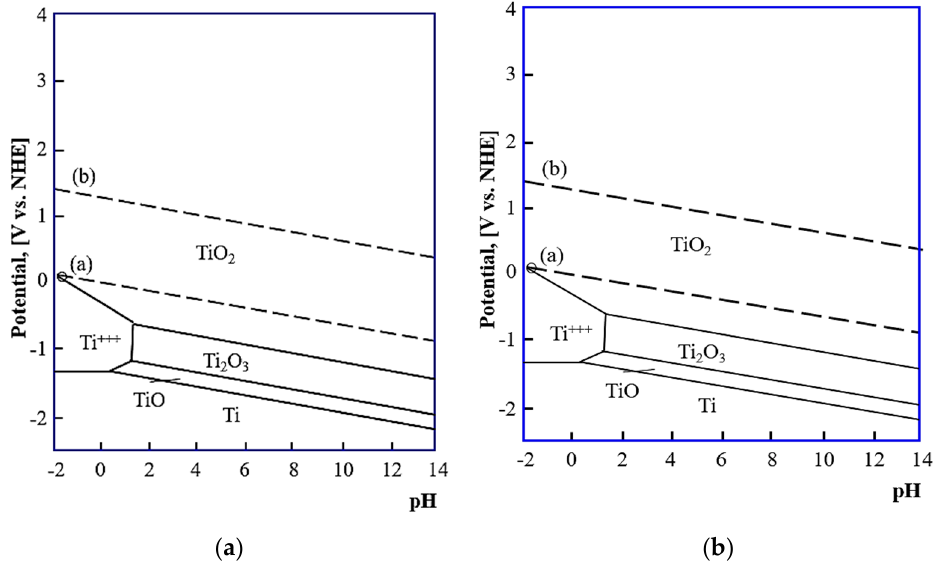
Figure 5. Pourbaix diagram for ( a ) titanium at T = 37 °C; ( b ) for zinc. For the samples with the ZnO layer, regardless of the pH of Ringer’s solution, the OCP potential gradually increased. It was associated with a thickening of the oxide film and/or corrosion products layer on the samples. Additionally, the OCP values of that same pH of Ringer solution were higher for the samples with the ZnO layer as compared to the samples in the initial state. In the Ringer solution of pH = 7.4, the OCP potential of the M2 sample group presents some oscillations. This can be related to some instability of ZnO oxide films in test